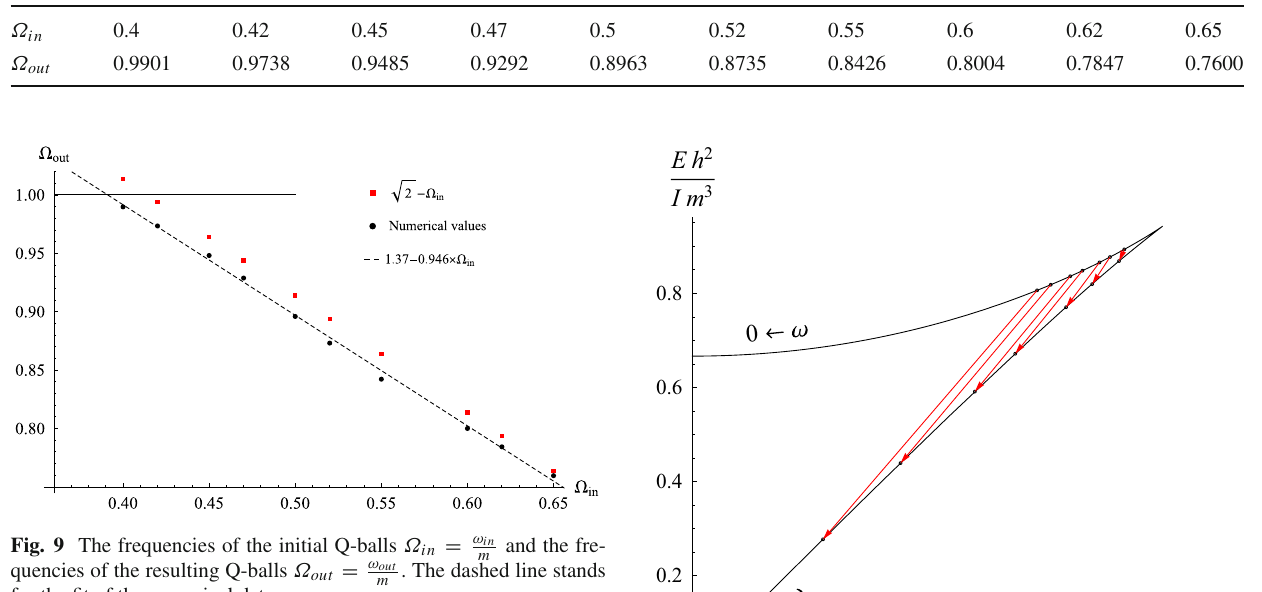
and the fre- m . The dashed line stands m